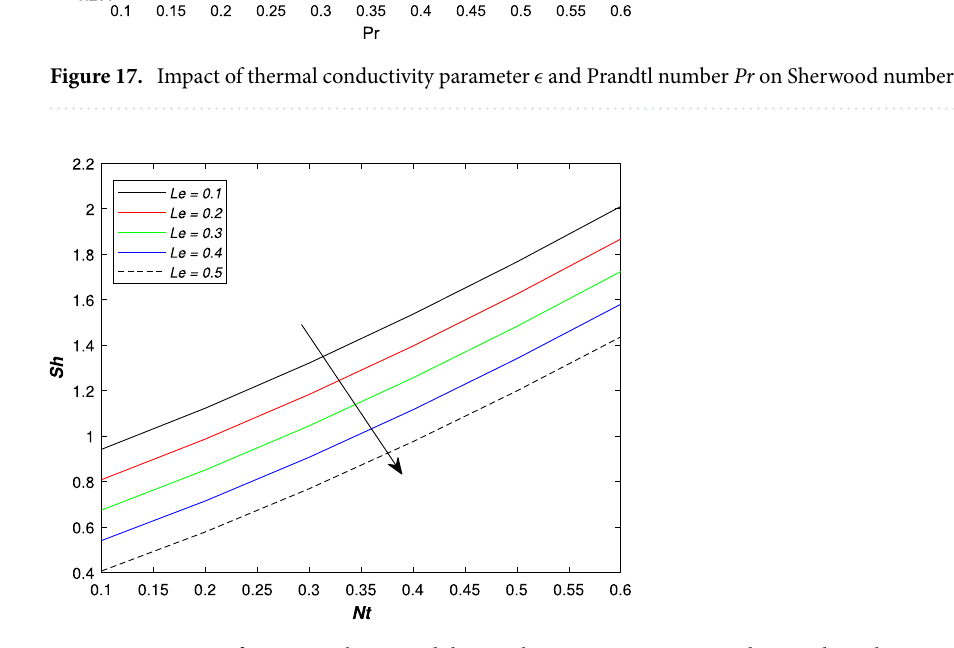
Figure 18. Impact of Lewis number Le and thermophoresis parameter Nt on sherwood